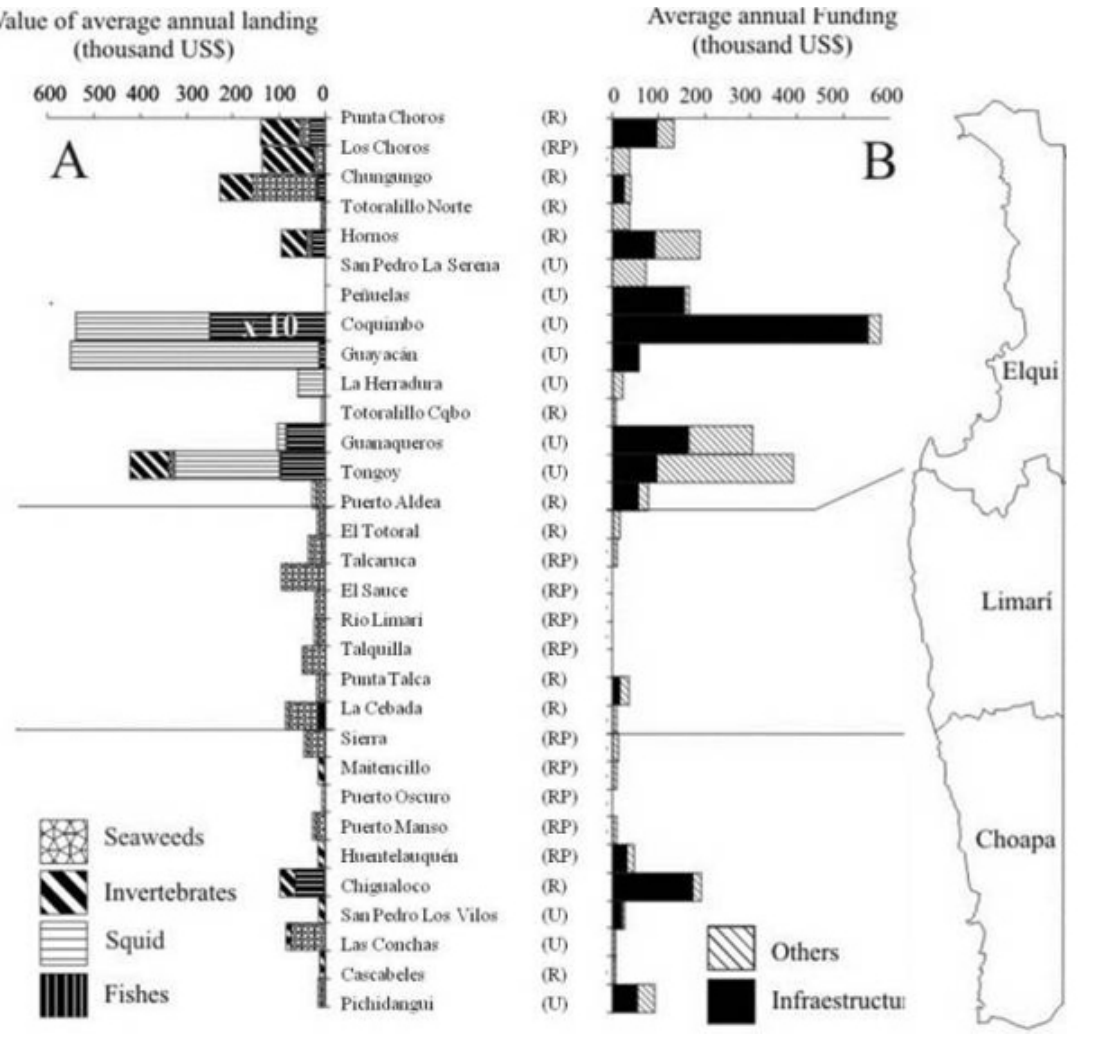
Fig. 2 . Distribution of average annual landing (A) and average annual funding (B) for each of the caletas in Coquimbo Region during 10 years in the period 1996–2007. Landing (A) is separated by resource, and funding (B) is separated by funding lines. In (B), the type of caleta is indicated: R = rural; RP = rural located on privately owned land; U = urban. For Coquimbo, the represented fish landings have to be multiplied by